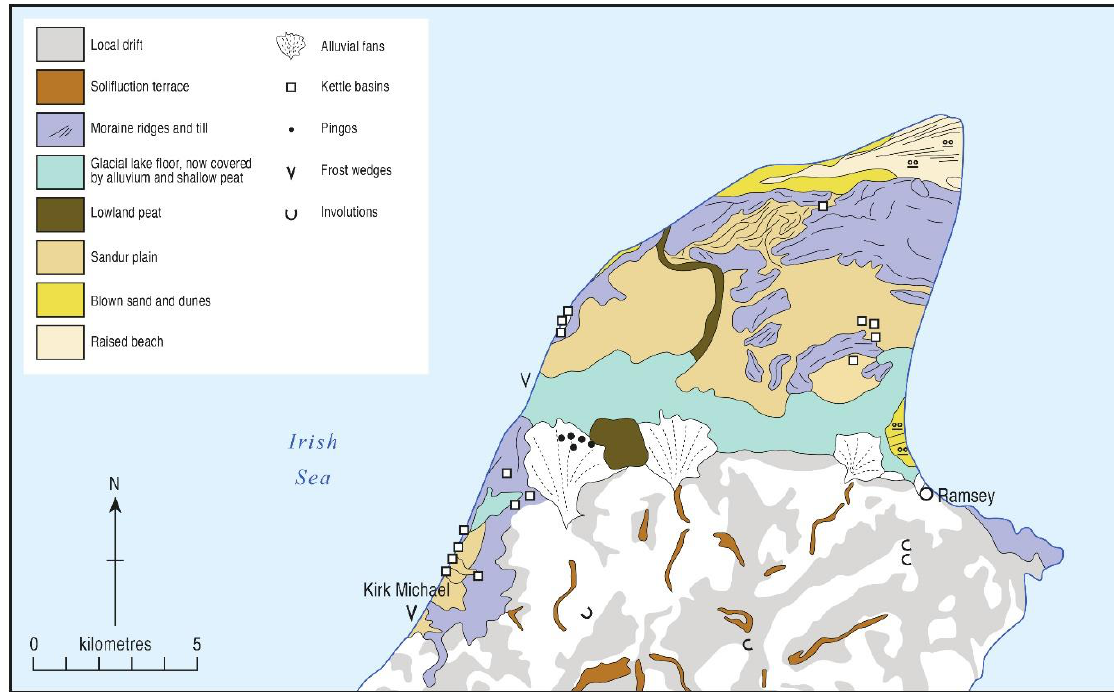
Figure 2. Glacial geomorphology of the northern part of the Isle of Man, after Chadwick et al. [47], also showing the main areas of lowland peat near Ballaugh and in the Lhen Trench.